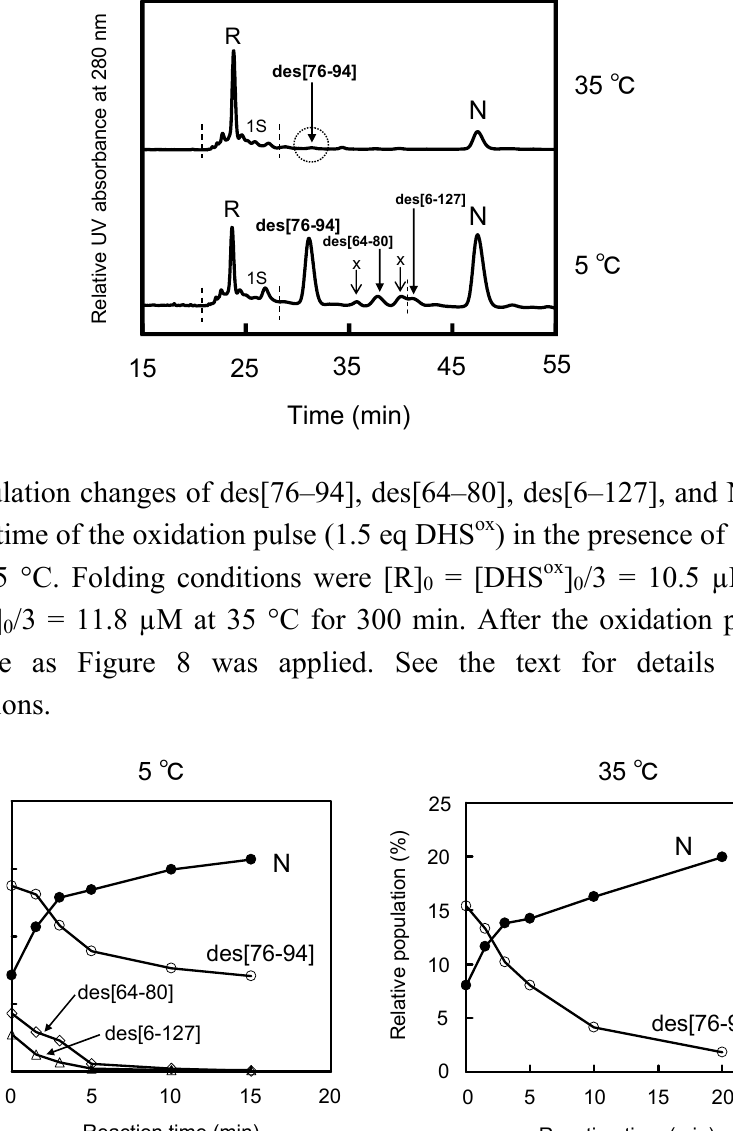
Figure 8. HPLC chromatograms of the sample solutions (with AEMTS blocking) obtained from the oxidation pulse experiments of HEL at 5 and 35 °C and pH 8.0 in the presence of 2 M urea. Folding conditions were [R] = [DHS ox ] /3 = 11.8 µM at 5 °C and 0 0 [R] = [DHS ox ] /3 = 10.1 µM at 35 °C for 300 min. Oxidation pulse conditions were 1.5 eq 0 0 DHS ox for 3 min at 5 °C and for 20 min at 35 °C. The reduction pulse conditions were 6 mM DTT red for 3 min at 5 °C and 1 mM DTT red for 2 min at 35 °C. See the text for details of the HPLC analysis conditions.